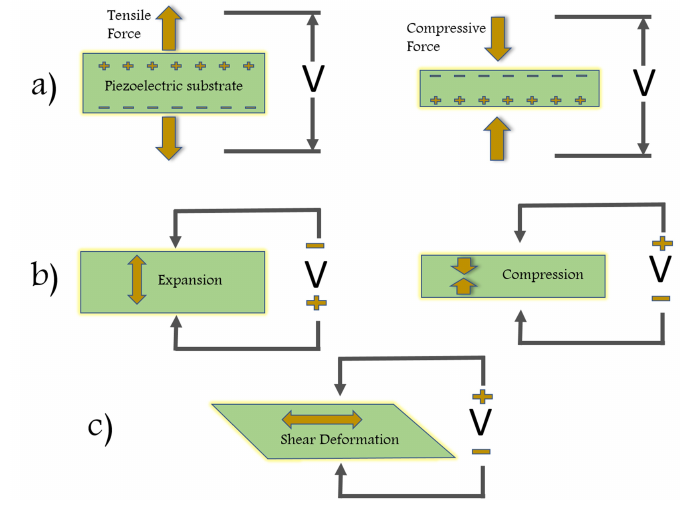
Figure 1. Schematic representation of the longitudinal direct ( a ); converse ( b ); and shear ( c ) piezoelectric effects.